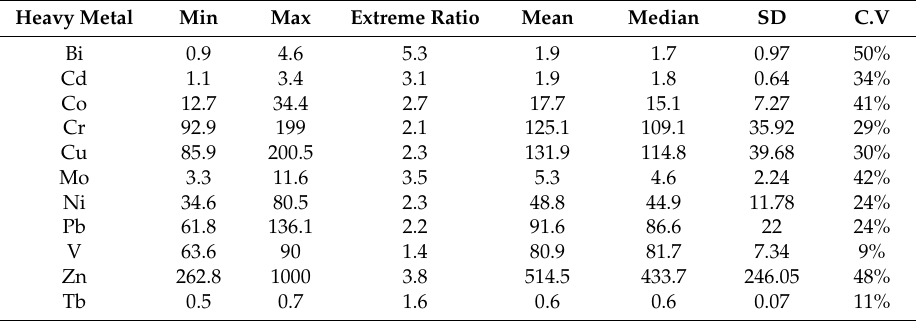
Table 2. Statistics of dust Heavy metals of Beijing suburban in winter/mg/kg.